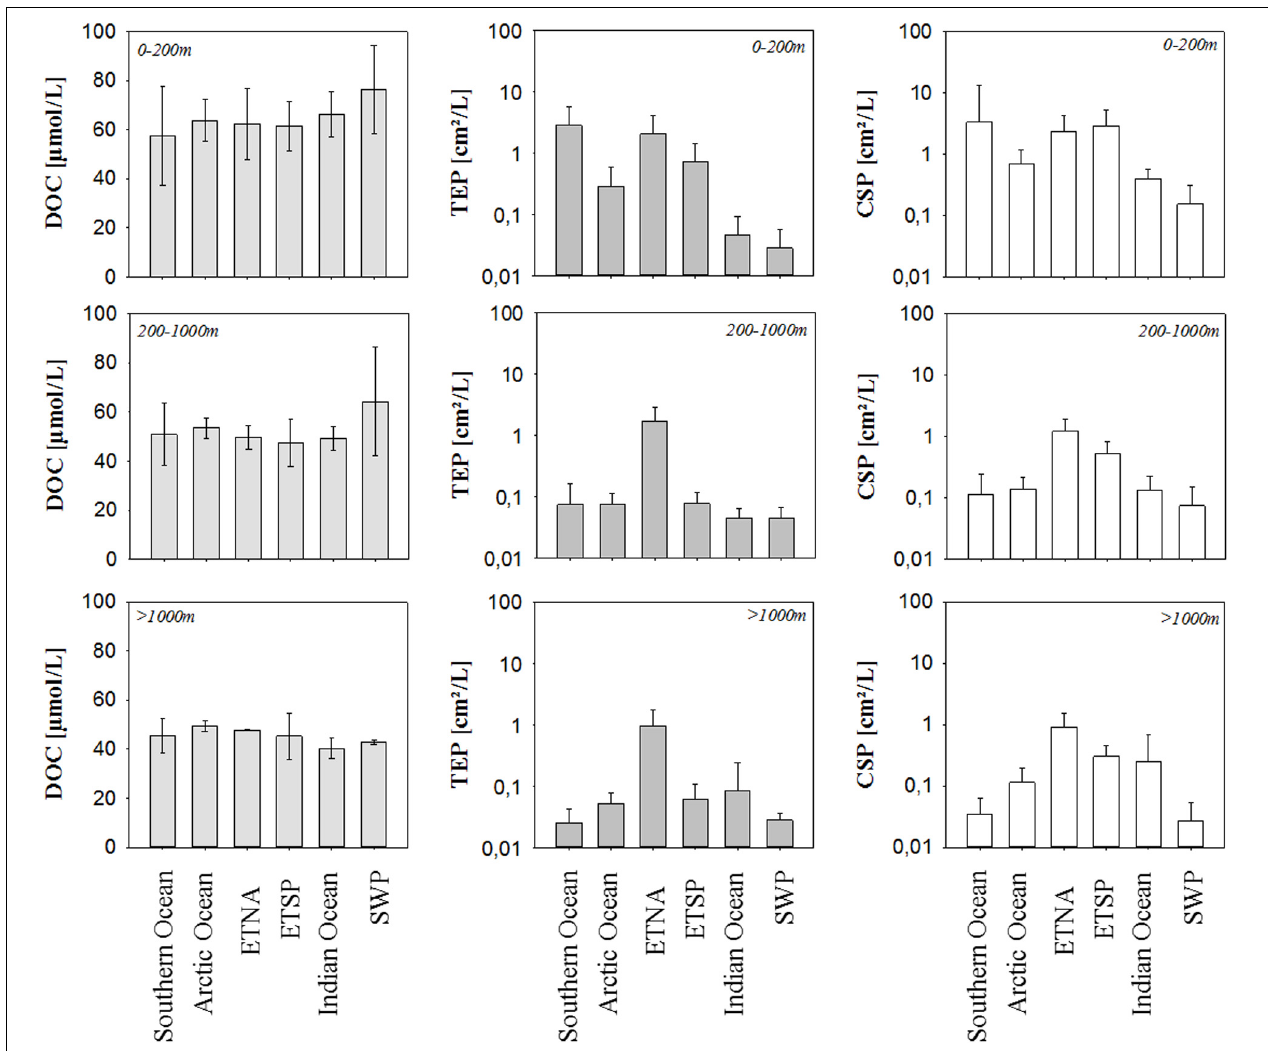
FIGURE 2 | Average concentrations of DOC, TEP, and CSP in the epipelagic, mesopelagic, and bathypelagic ocean of the six study sites. Error bars indicate ± 1 SD. Note log scale for TEP and